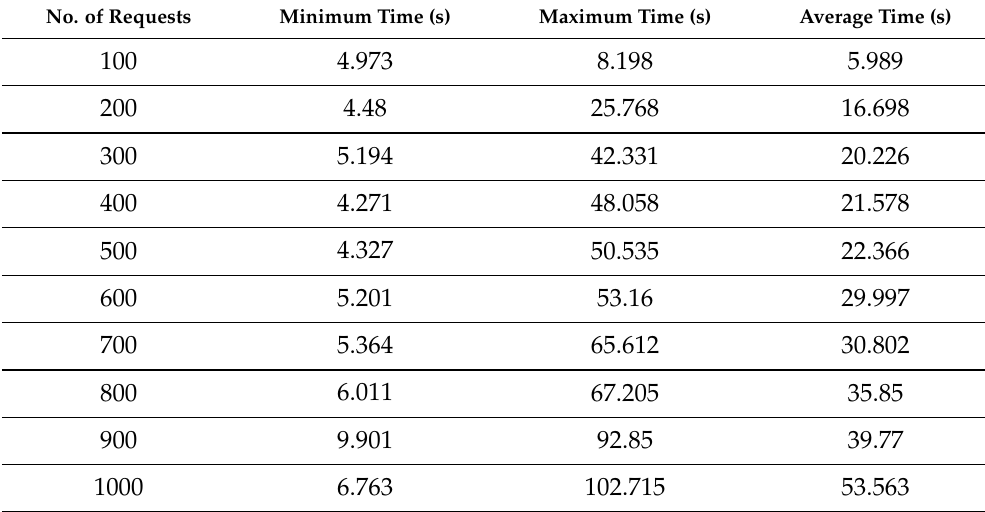
Table 5. (The results of Experiment 2.3): the response time (in the second) handling concurrent requests using three instances of the SEMi